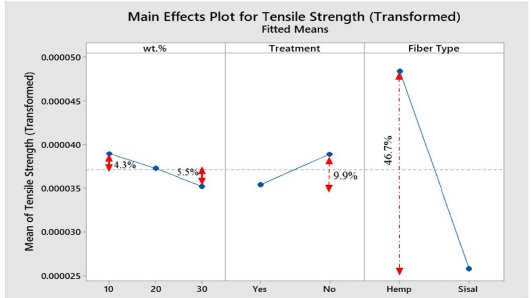
Figure 4. The main effect plot for the mean transformed tensile strength.